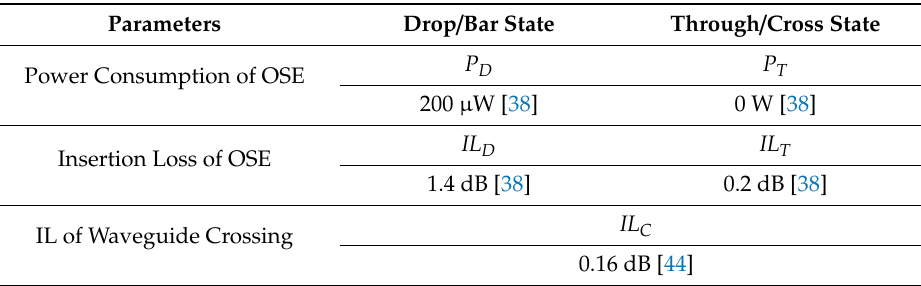
Table 8. Specifications and performance parameters.